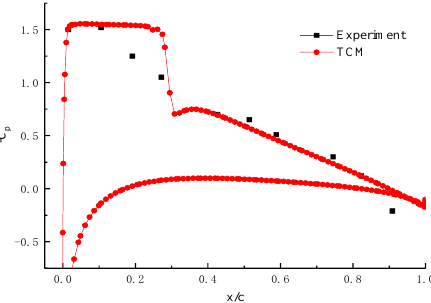
Figure 7. Comparison between experiment and TCM [26].